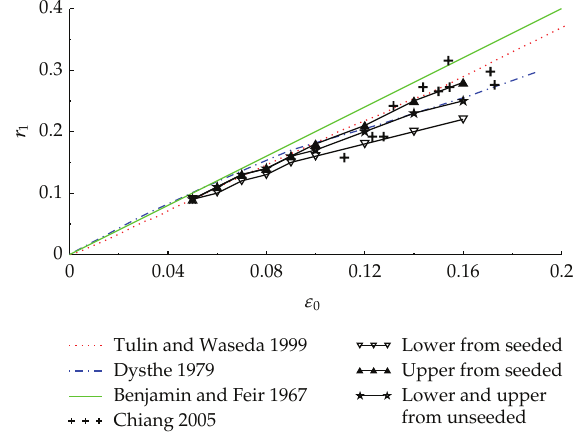
Figure 10: The MUC for di ff erent carrier wave steepness.